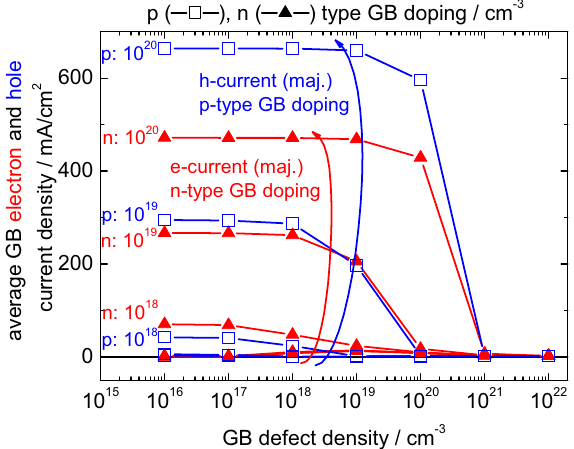
Fig. 6. Average GB electron (red symbols) and hole (blue symbols) current density shown over the GB defect density for different GB doping concentrations for p -type GB (open squares) and n -type GB (full triangles). The majority-carrier (maj.) current increase is